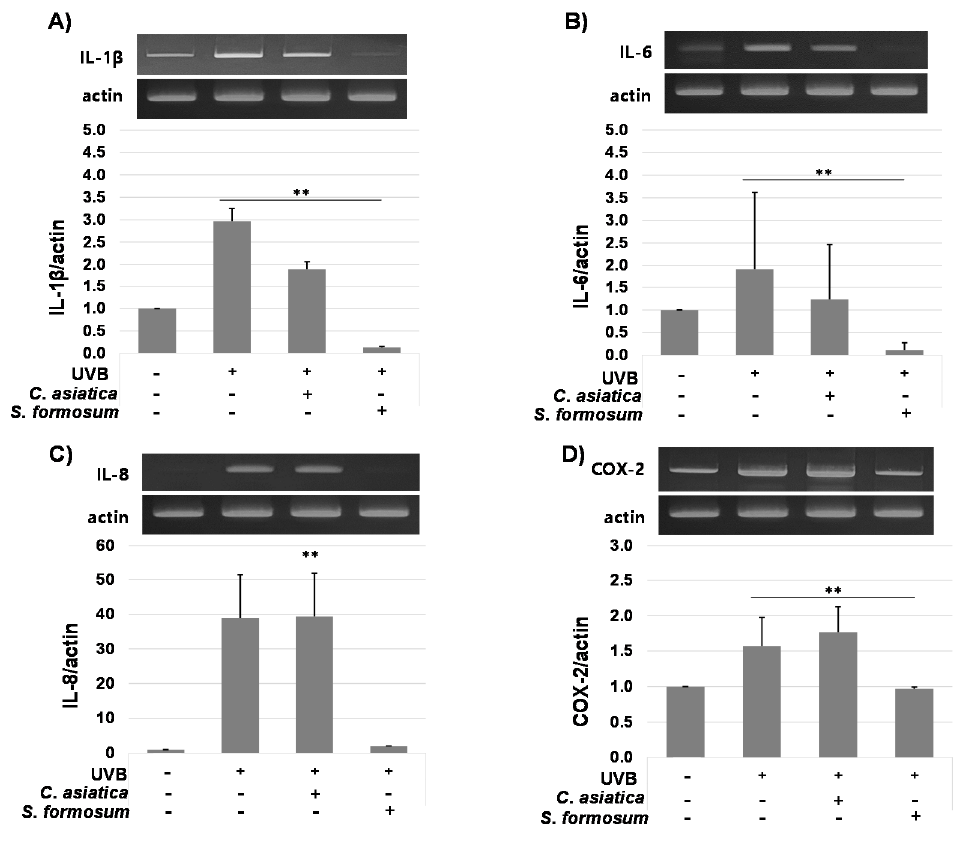
Figure 2. Relative mRNA expression of proinflammatory cytokines ( A – C ) and COX-2 ( D ) after treatment of Syzygium formosum leaf extract or Centella asiatica extract on the HaCaT cells radiated with ultraviolet-B. Gene expression levels were compared with a house keeping gene, actin. Statistical significance ( p < 0.01) is indicated with double asterisks (**).